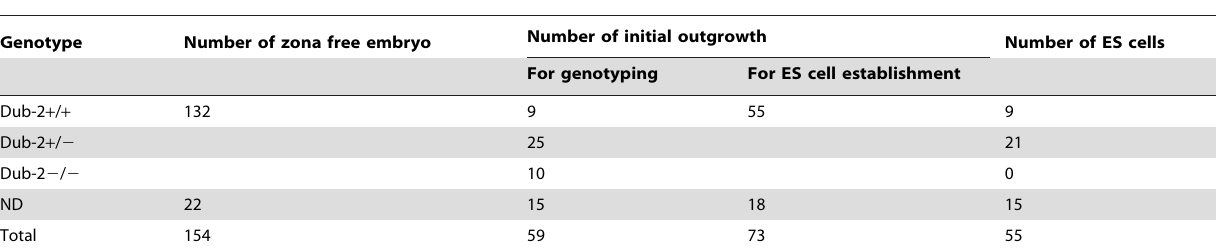
Table 3. The number of hatching status of E3.5 embryos after 114 hrs of ZP-free culture in vitro .